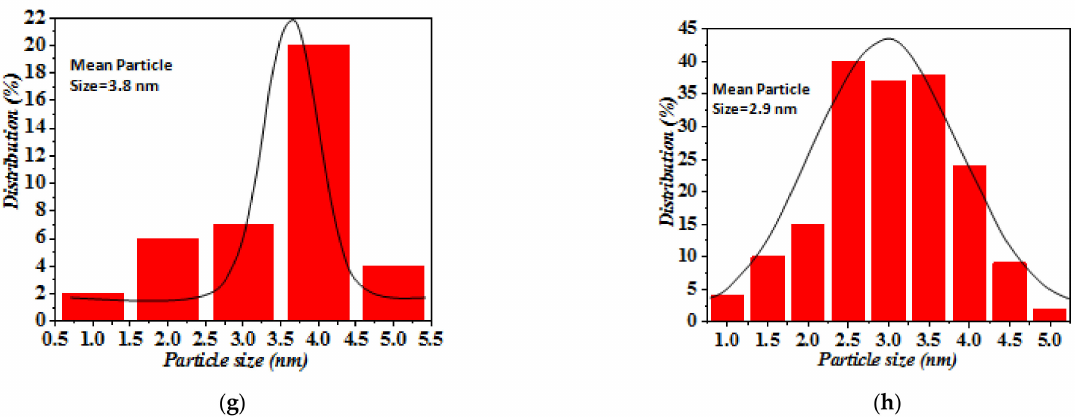
Figure 2. XRD patterns ( a , b ), STEM images ( c , d ) and particle size distribution ( e , f ) TiO 2 , ( g , h ) Pt 0 of One-Nozzle ( a , c , e , g ) and Double-Nozzle FSP particles ( b , d , f , h ). In all cases, the data refers to 0.5% NM 0 /TiO 2 nanoparticles. In STEM images, the lighter-gray spheres represent the Pt nanoparticles on the TiO 2